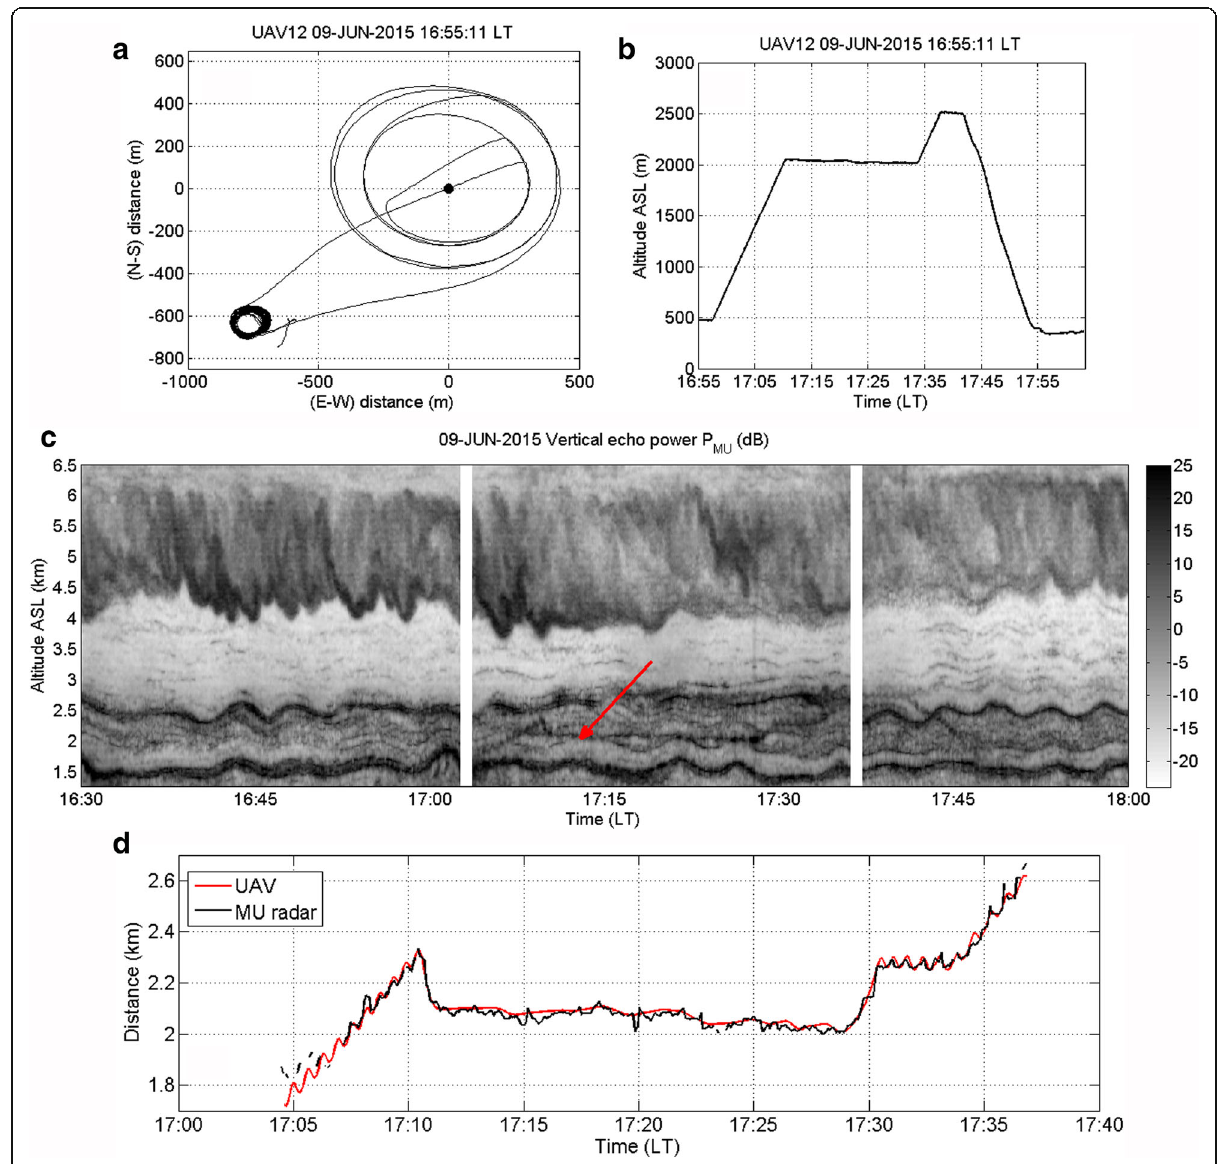
Fig. 4 a Horizontal distance of UAV 12 with respect to the center of the radar antenna beam located at (0,0). b Height vs. time of UAV 12. c Time-height cross section of radar echo power (in dB, arbitrary scale) in range imaging mode, after doing the Capon processing, at vertical incidence from 16:30 LT to 18:00 LT on June 9 in the height range 1.27 – 6.5 km ASL. The gaps correspond to radar stops. The trace of UAV 12, pointed out by the red arrow , can be seen below 2.6 km ( d ). Red UAV distance from the center of the radar antenna vs. time between 17:40 LT and 18:20 LT, Black the corresponding echo power peaks selected manually and attributed to the